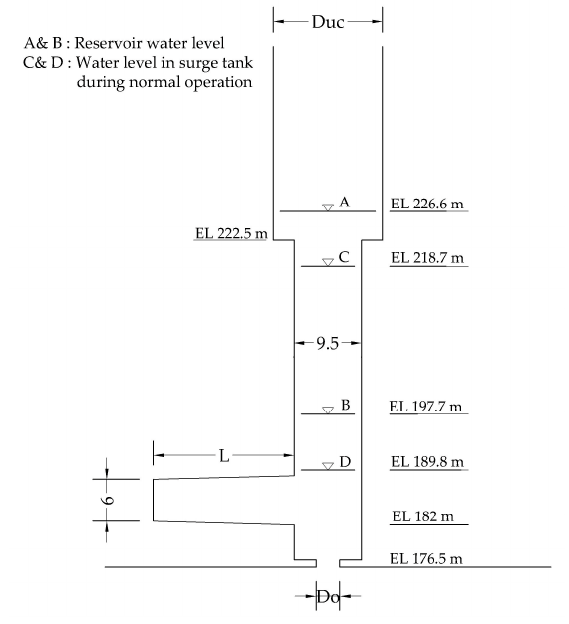
Figure 4. Variables and fixed dimensions of the double chamber surge tank. Table 2. Variation in area of the surge